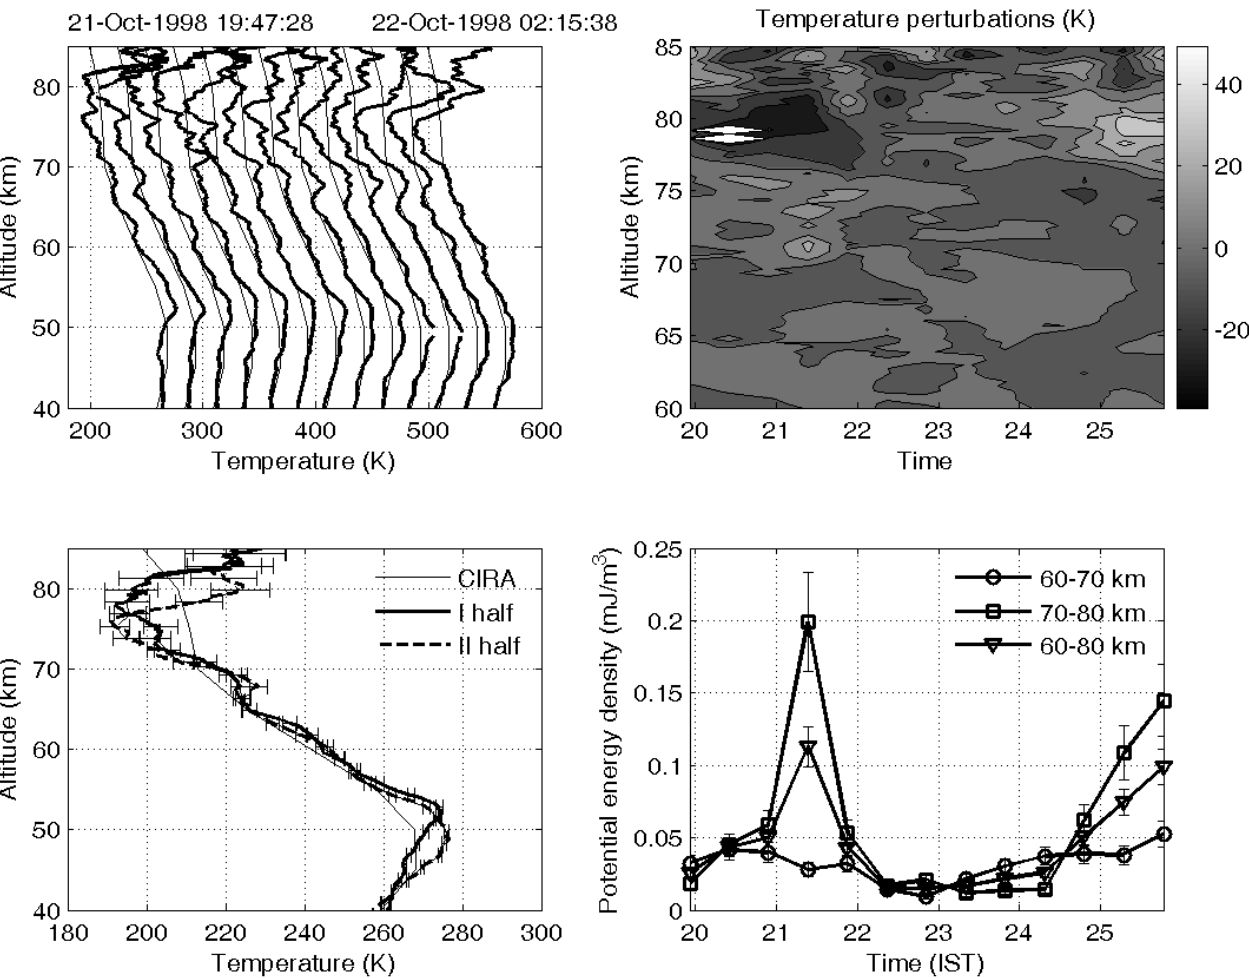
Fig. 1. (a) Sequence of altitude profiles of temperature (top left), (b) temperature profiles averaged for the first and second half of the observation period (bottom left), (c) contour plot showing temperature perturbations from the night mean profile (top right) and (d) time variation of potential energy averaged for 60–70km, 70–80km and 60–80km for 21–22 October 1998 (bottom